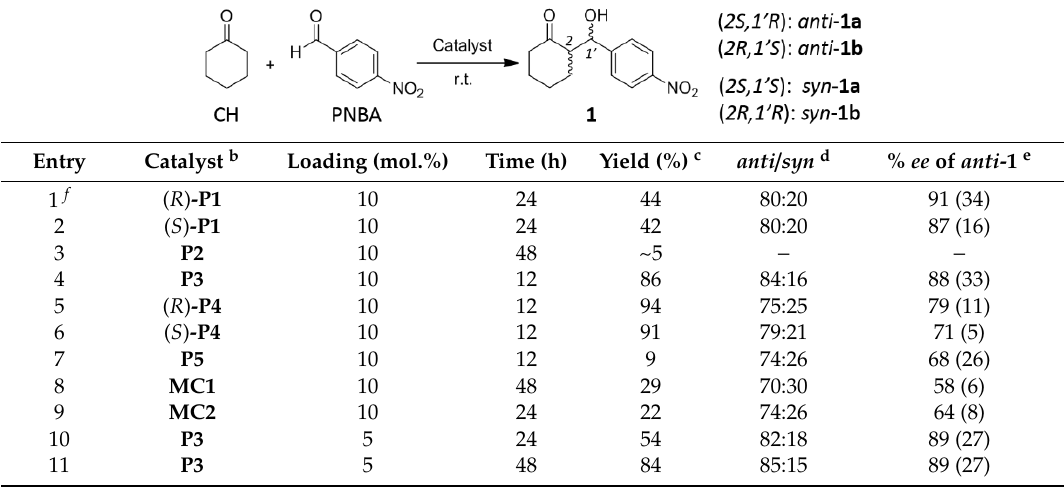
Table 1. Aldol reaction of cyclohexanone with 4-nitrobenzaldehyde catalyzed by various catalysts a .